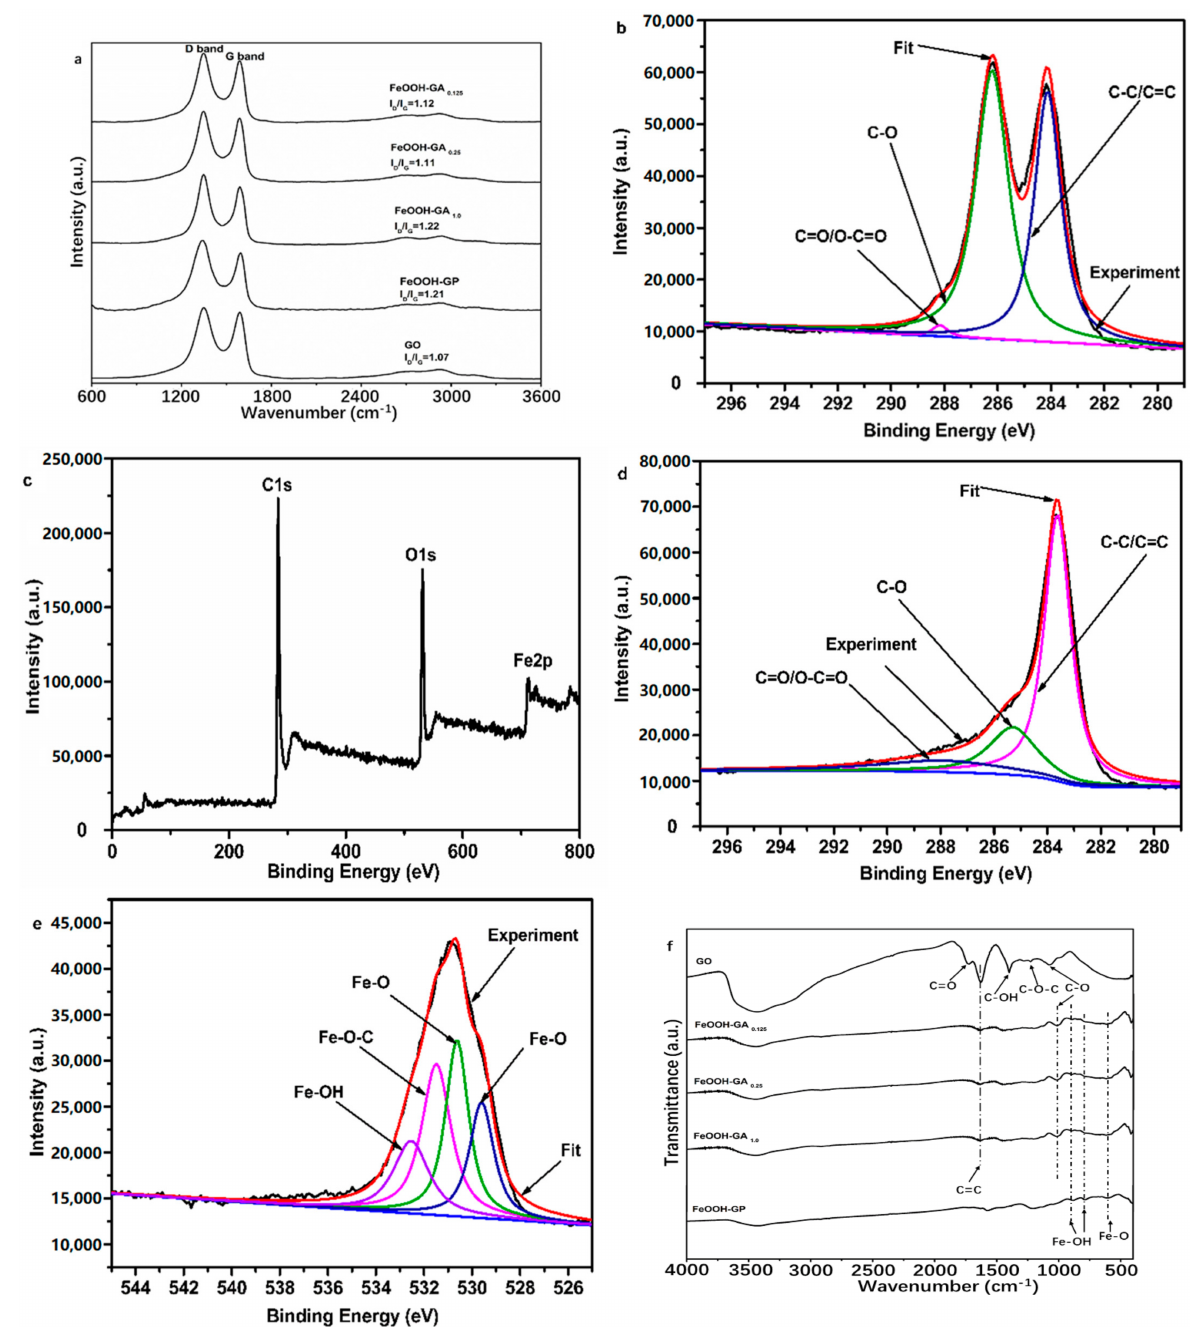
Figure 3. The Raman spectra of GO, FeOOH-GA 0.125 , FeOOH-GA 0.25 , FeOOH-GA 1.0 and FeOOH-GP ( a ). The High resolution XPS spectrum of C 1s of GO ( b ). The full XPS spectrum of FeOOH-GA 0.25 ( c ). The High resolution XPS spectra of C 1s ( d ) and O 1s ( e ) of FeOOH-GA 0.25 . The FT-IR spectra of GO, FeOOH-GA 0.125 , FeOOH-GA 0.25 , FeOOH-GA 1.0 and FeOOH-GP ( f ). EDS patterns confirm the presence of elements C, O, Fe, and S in FeOOH-GA 0.125 (Figure S2b), FeOOH-GA 0.25 (Figure S2c), FeOOH-GA 1.0 (Figure S2d), and FeOOH-GP (Figure S2e). Amongst them, the element Fe and the element O display strong signals. All Fe signals come from FeOOH nanorods. The atom content of Fe element is 3.82% in FeOOH-GA 0.125 , 6.39% in FeOOH-GA 0.25 , 10.98% in FeOOH-GA 1.0 , and 6.46% in FeOOH-GP, respectively, increasing with the elevation of the FeSO 4 · 7H 2 O mass, indicating the content of FeOOH nanorods on reduced graphene oxide sheets. These values are